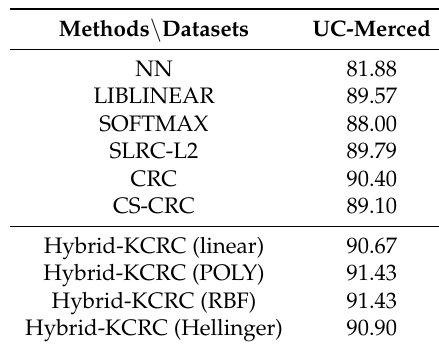
Table 1. Comparison with several classical classification methods on the UC Merced Land Use Dataset